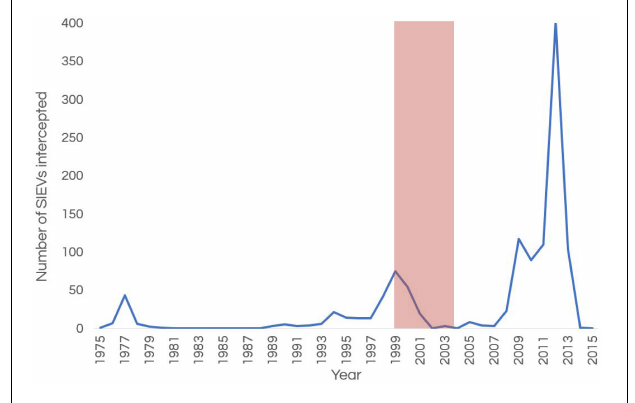
FIGURE 7 | Number of Suspected Illegal Entry Vessels (SIEVs) entering Australia’s border at Ashmore over time. The pink band shows the time of marked decline in sea snake numbers and diversity at Ashmore. The increased number of SIEVs arriving after 2007 was due a change of policy by the then government and not a sudden increase of numbers of